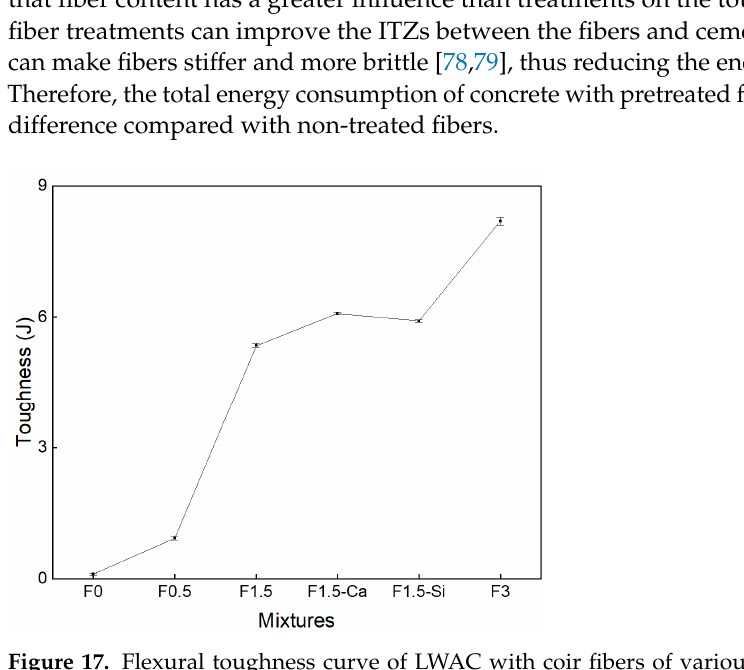
Figure 17. Flexural toughness curve of LWAC with coir fibers of various contents and different treatments at 28 days.